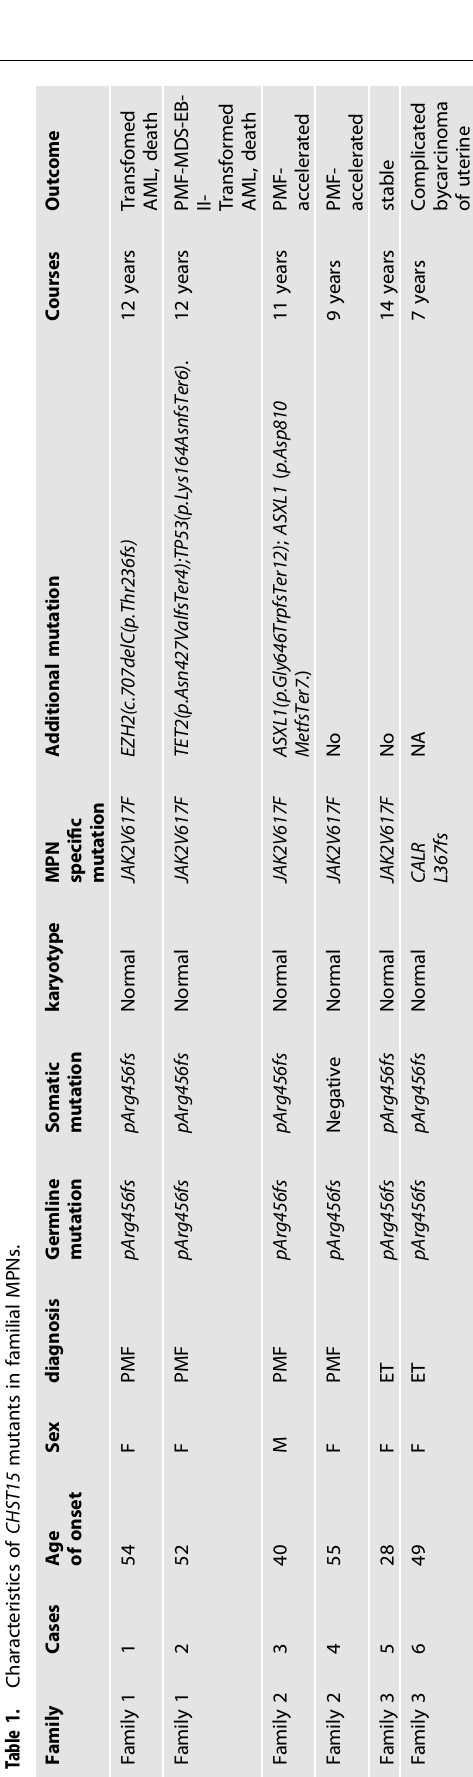
decreased CHST15 expression (Figs. 4A, S2), consistent with HEL cells harboring mutant CHST15 (Figs. 4B, S3). The qRT-PCR results indicated that CHST15 mRNA expression was obviously decreased in patients with familial MPN compared with patients with sporadic MPN and normal subjects and there were signi fi cant difference between familial MPN and sporadic MPN or normal controls ( p < 0.05) (Fig.